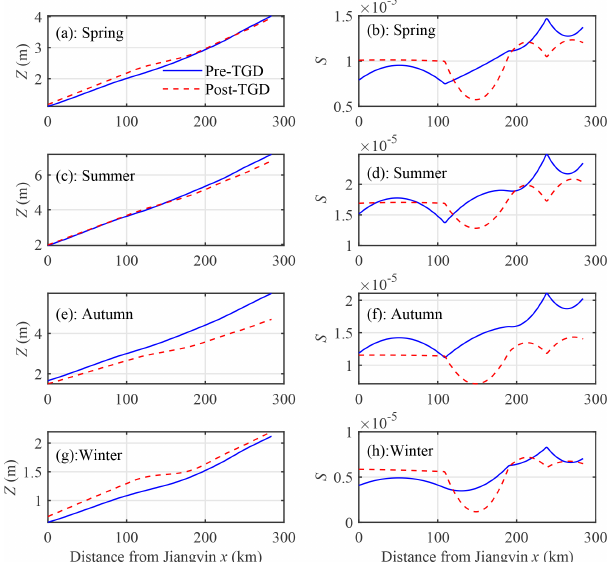
Figure 5. Longitudinal variability of reconstructed water level Z (a, c, e, g) and its slope S (b, d, g, h) along the upper YRE (from Jiangyin to Wuhu) during four seasons (spring: a, b ; summer: c, d ; autumn: e, g ; winter: g, h ) for the climatological year during the pre- and post-TGD periods.